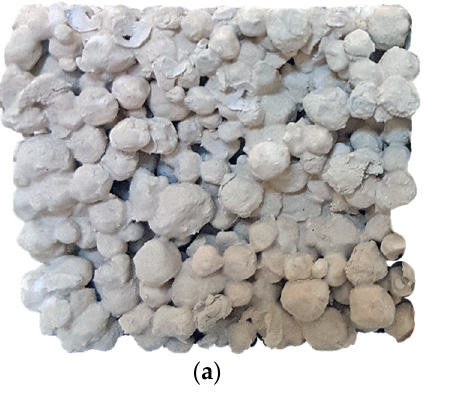
Table 4. Recalculated w/c for each CP level and theoretical water demand of increasing biomass